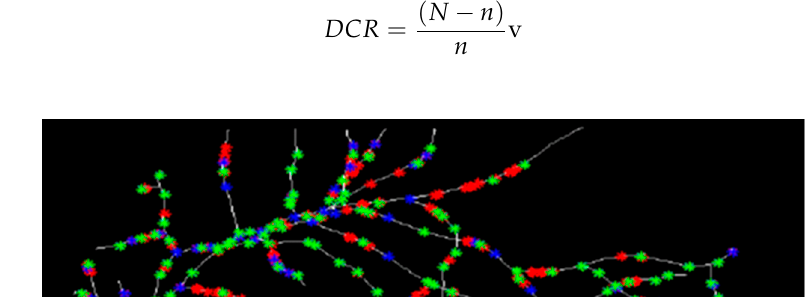
Figure 8. Detection of the endpoints and bifurcation points: ( a ) Endpoints; ( b ) Bifurcation points.